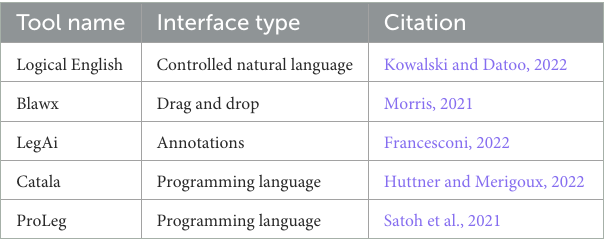
TABLE 1 Selected